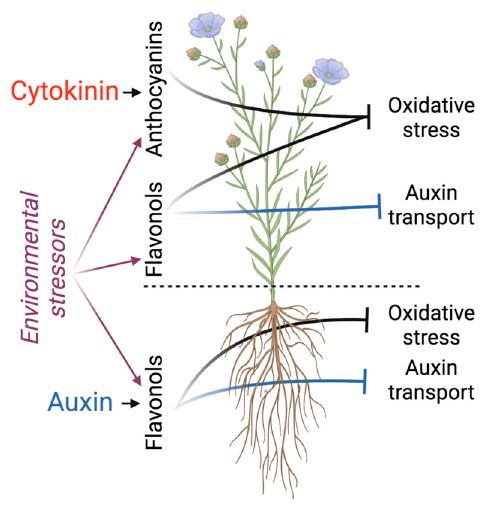
Figure 2. Auxin and cytokinin interactions with flavonoids in shoots and roots. Cytokinin, the promoter of shoot growth, upregulates the biosynthesis of anthocyanins in shoots, strengthening the antioxidative system poised to combat the excess of ROS generated, for example, by photosynthesis or by the action of environmental stressors. Auxin in roots upregulates the biosynthesis of flavonols, which modify auxin action by inhibiting auxin transport and counteracting auxin-induced ROS accumulation. The flavonoid-dependent inhibition of auxin transport is not restricted to roots—it also acts in shoots to shape petiole angle and leaf nastic development. In addition, flavonol synthesis is environmentally controlled, thus linking environmental fluctuations to changes in auxin action for optimal environmental adaptation.